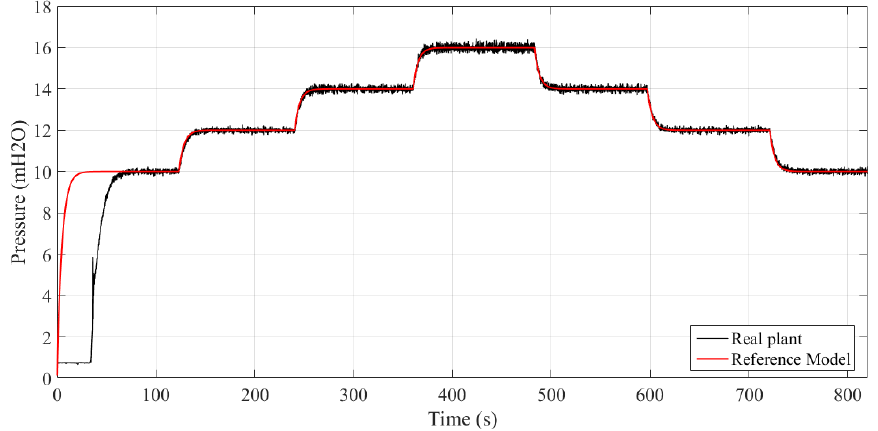
Figure 9. System responses for different setpoints.